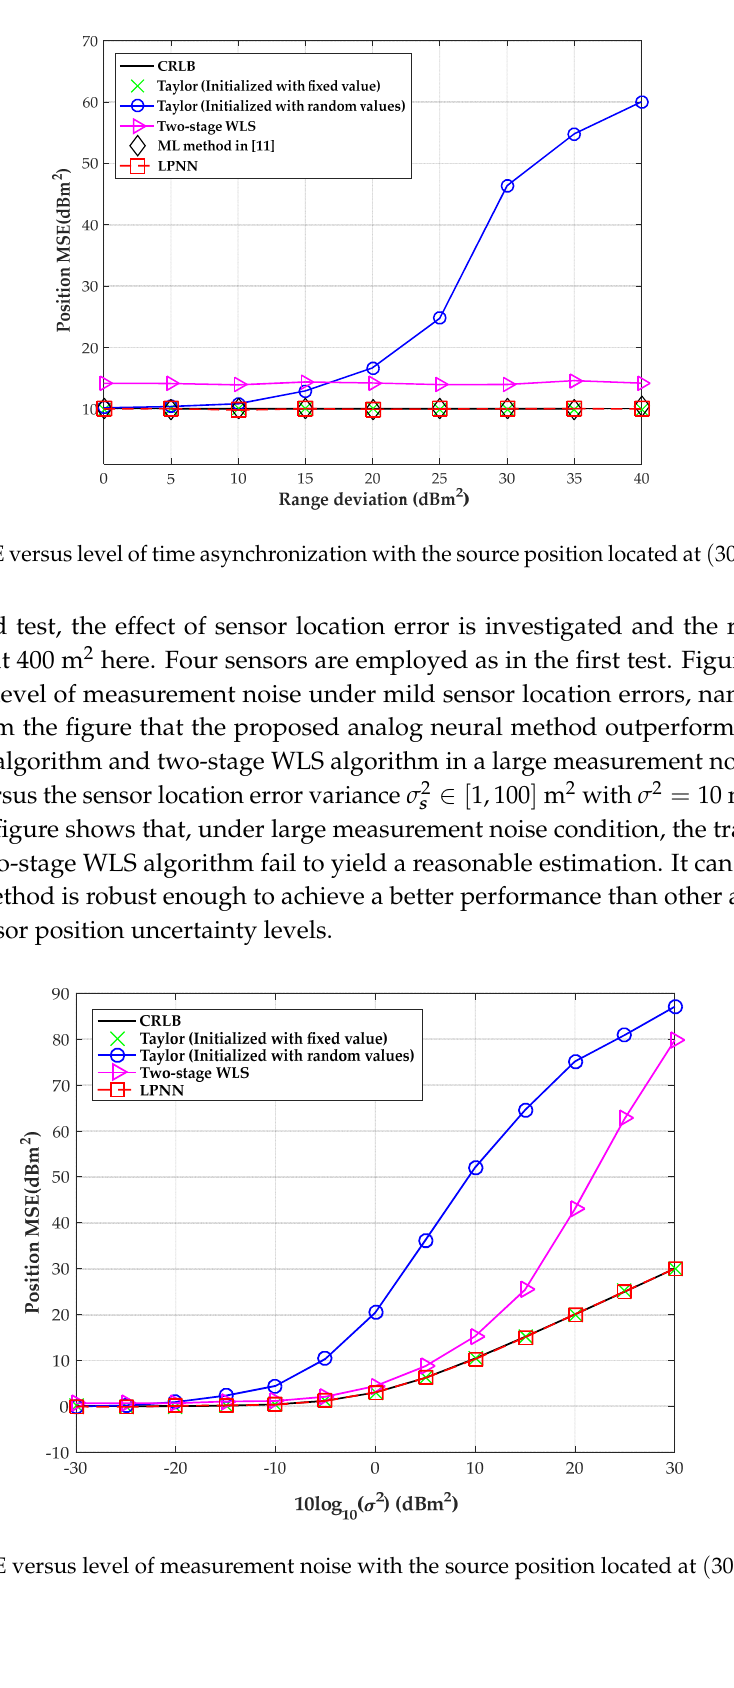
Figure 11. MSE versus level of measurement noise with the source position located at  (300, 280) m.